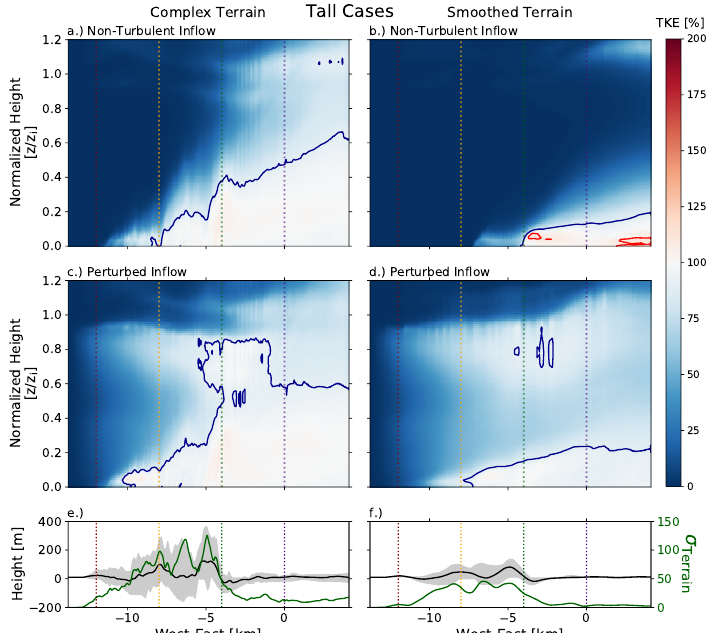
Figure 20. Same as Figure 15 but for the Tall cases. Panels ( a – d ) show the percentage of time- averaged TKE averaged along the y -direction with normalized height. Dark blue lines contour the 90th-percentile and red lines contour the 110th-percentile. Panels ( e , f ) show the y -average of terrain height (black line) with the maximum and minimum of terrain heights (filled gray) on one axis and the variance of terrain height along the y-direction (green) on the opposite axis. Panels ( a , c , e ) (left column) show fields for simulations over complex terrain. Panels ( b , d , f ) (right column) show fields for simulations over smoothed terrain. Panels a and b show results for non-turbulent cases, while c and d show results for the perturbed